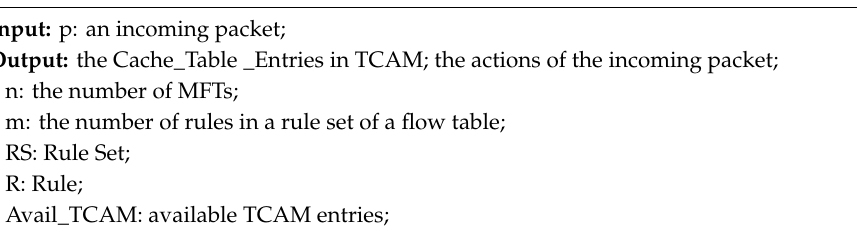
Algorithm 1 PipeCache